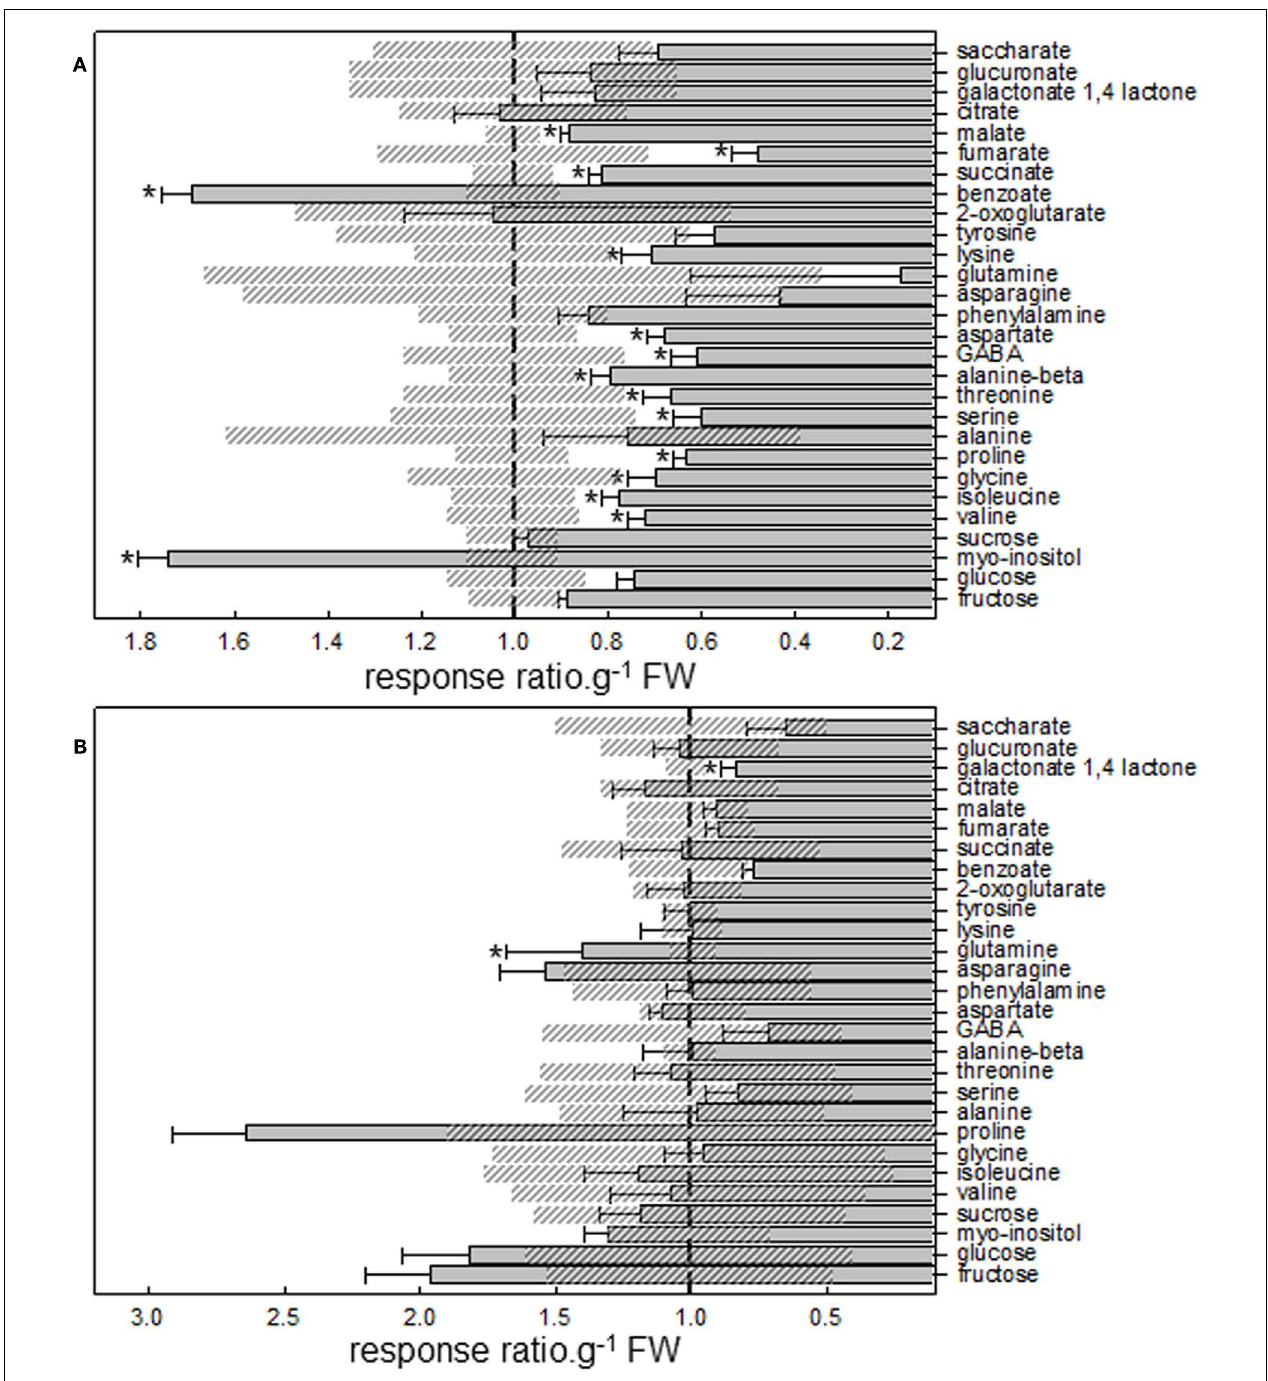
line).The values are the average ± SE (SE for control indicated with diagonal striped boxes) reported for five independent replicates and an asterisk indicates a value that was determined by Student’s t- test ( P < 0.05) to be significantly different from the respective untreated